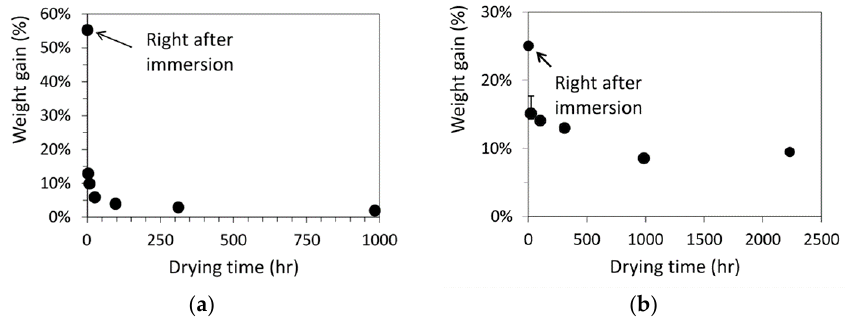
Figure 3. Weight gain of dog-bone specimens as a function of drying time after the immersion in ( a ) acetone for 40 min and ( b ) primer for 10 min. ( a ) acetone for 40 min and ( b ) primer for 10 min.